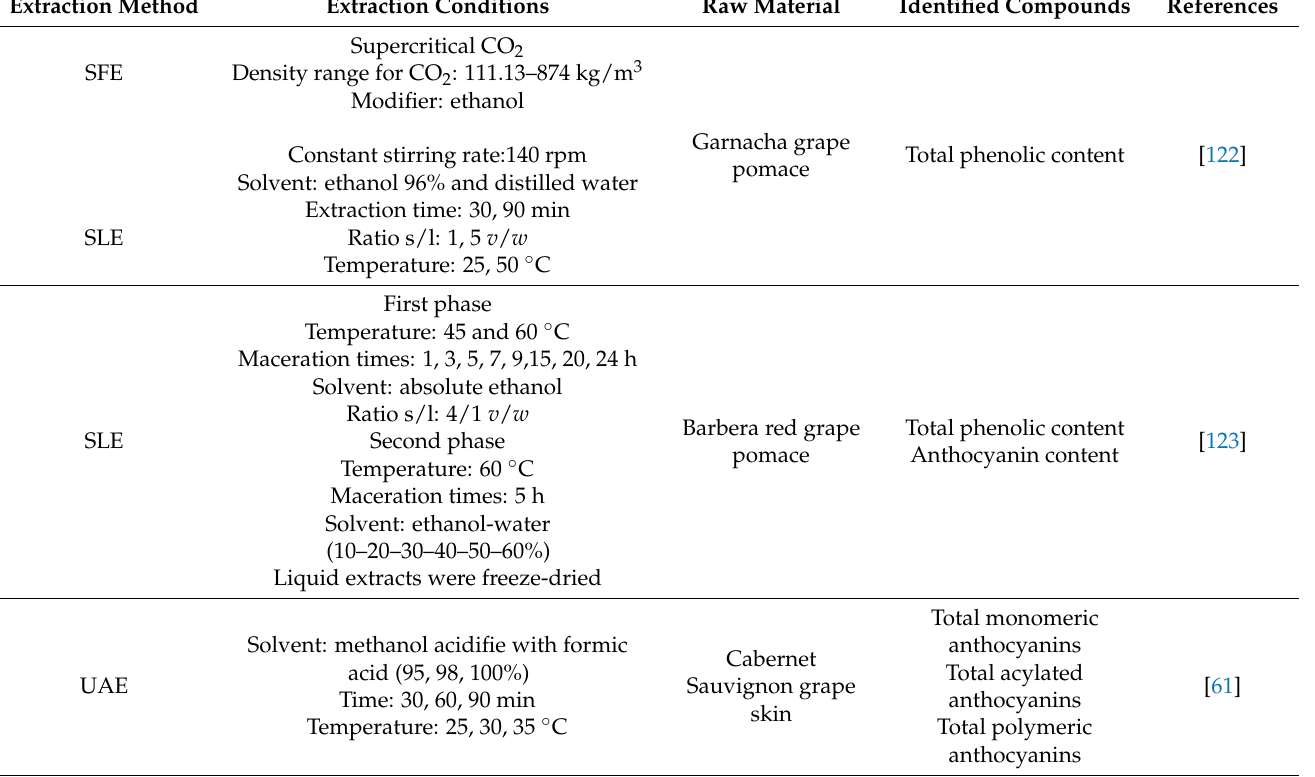
Table 2. Extraction techniques to obtain polyphenolic